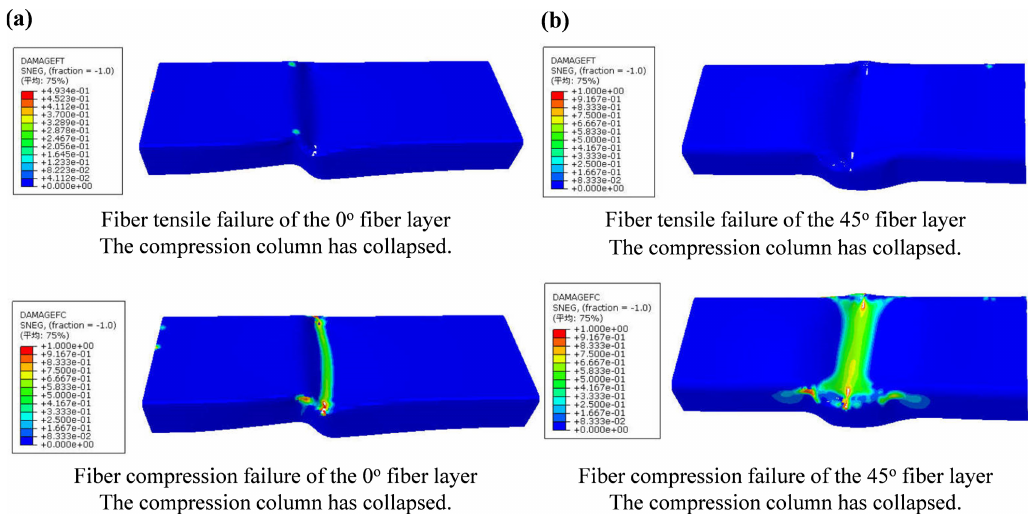
Figure 18: Fiber tensile and compression failure area distribution of compression columns at final failure state: (a) DCYG-A and (b) DCYG-B